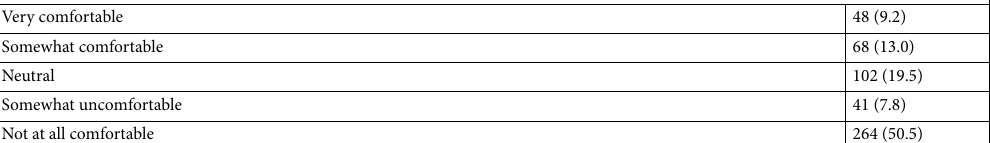
Table 2. Knowledge, attitude, preparedness and digital health acceptance toward COVID-19.